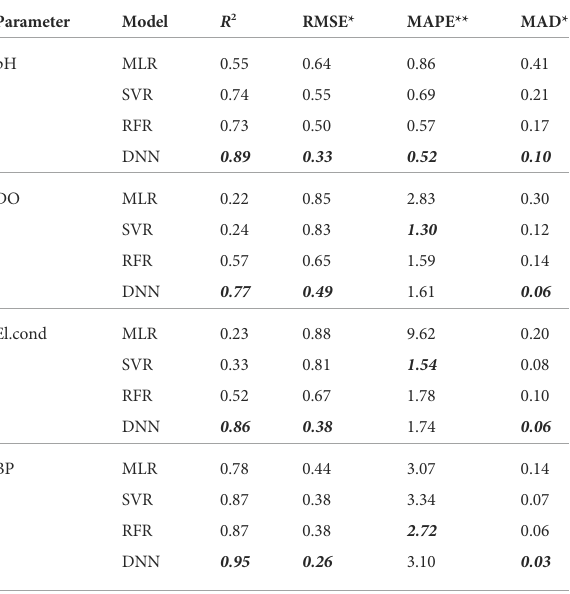
TABLE 2 Results of regression model